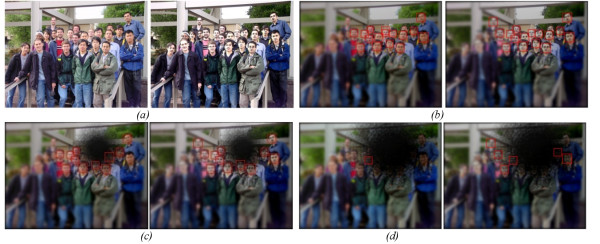
Testing the ability of detecting faces in original and cartoonized image with different level of macular degeneration. a) the original image to the left and the cartoonized version from it before the retina modelling, b) detection of faces on both the original image (left) and the cartoon image (right) without macular degeneration; only the foveal effect is shown here, c) with medium degeneration, and c) with severe degeneration.